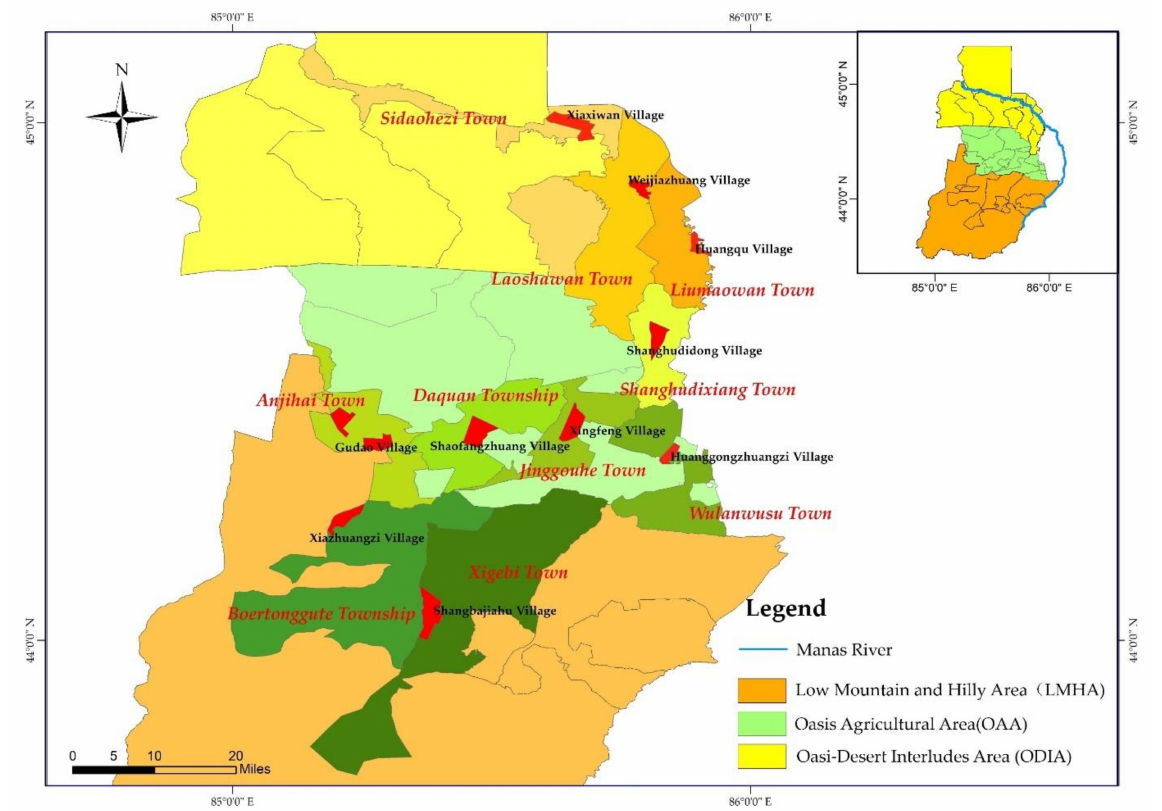
Figure 1. Location diagram of the study